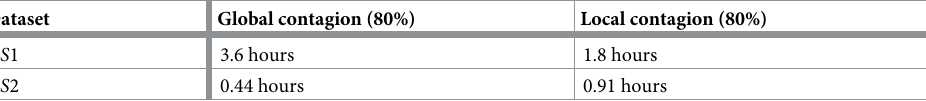
Table 5. Time when 80% of inter-retweet times of local and global contagion are reached, considering non-viral